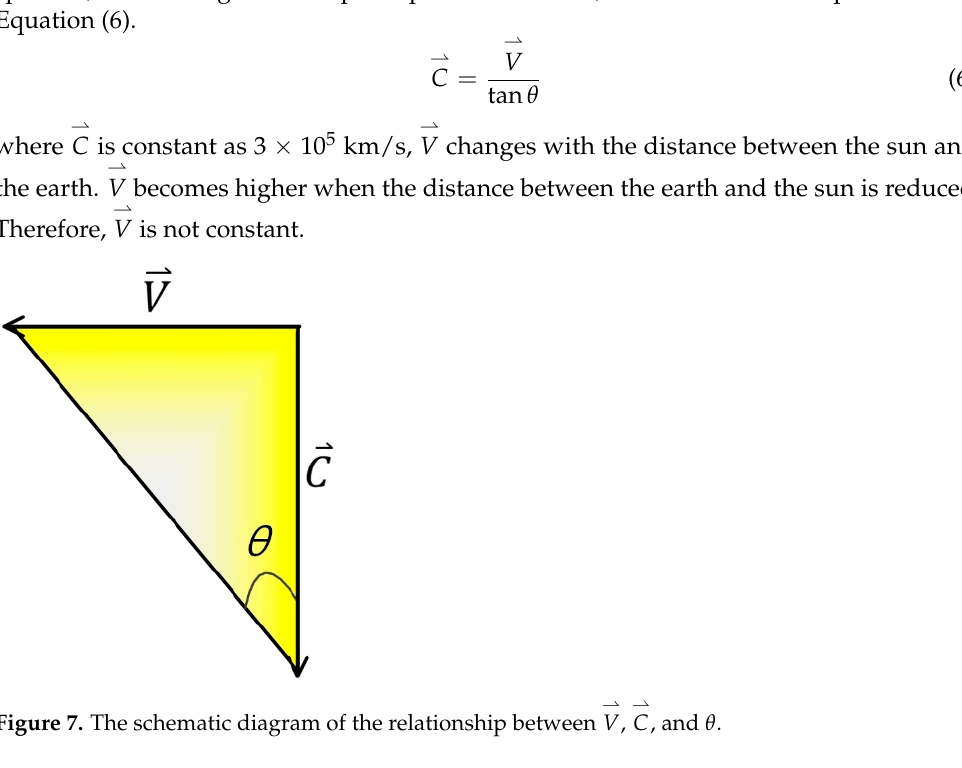
1 and its opposite Y